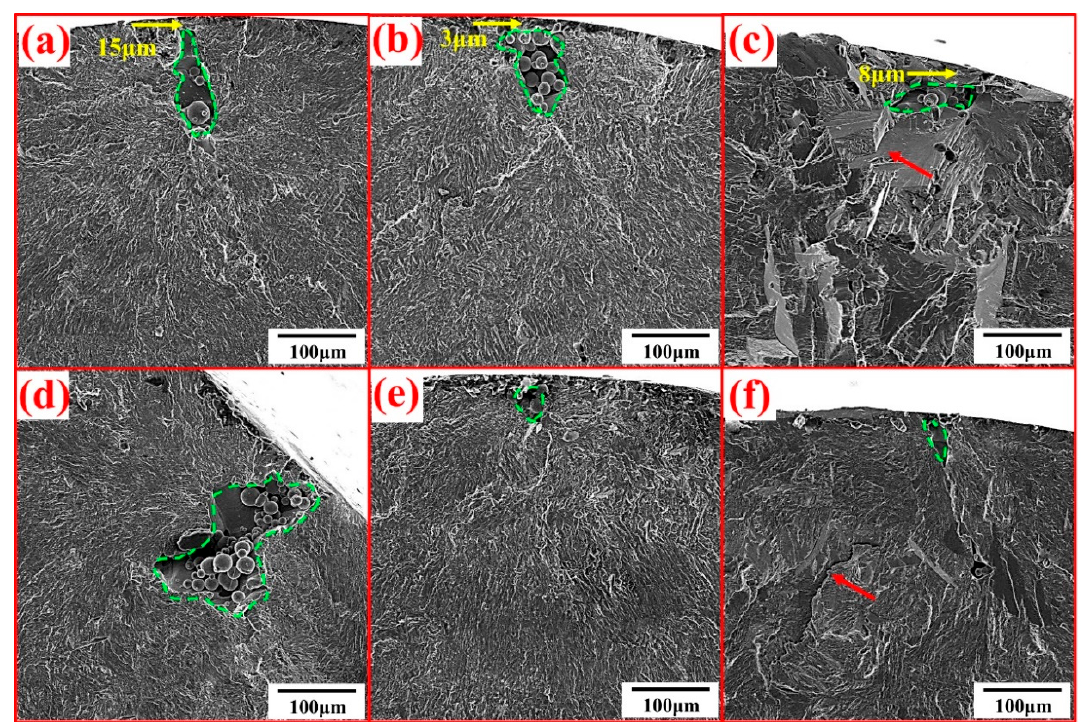
Figure 9. Macroscopic crack initiation zone of different specimens: ( a ) 850FC (2733000 cycles), ( b ) 950FC (575400 cycles), ( c ) 1050FC (78700 cycles), ( d ) 850WAC (1521300 cycles), ( e ) 950WAC (671100 cycles), ( f ) 1050WAC (141700 cycles).